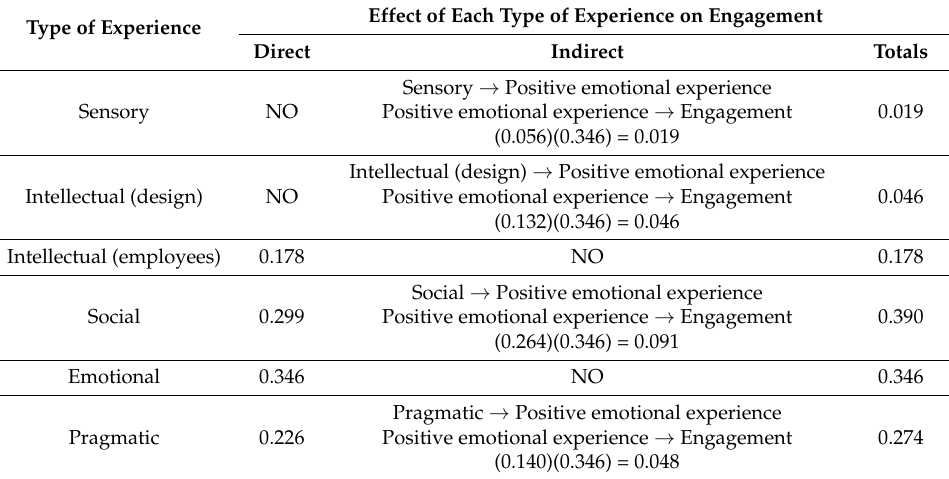
Table 7. Direct and indirect effects of type of experience on